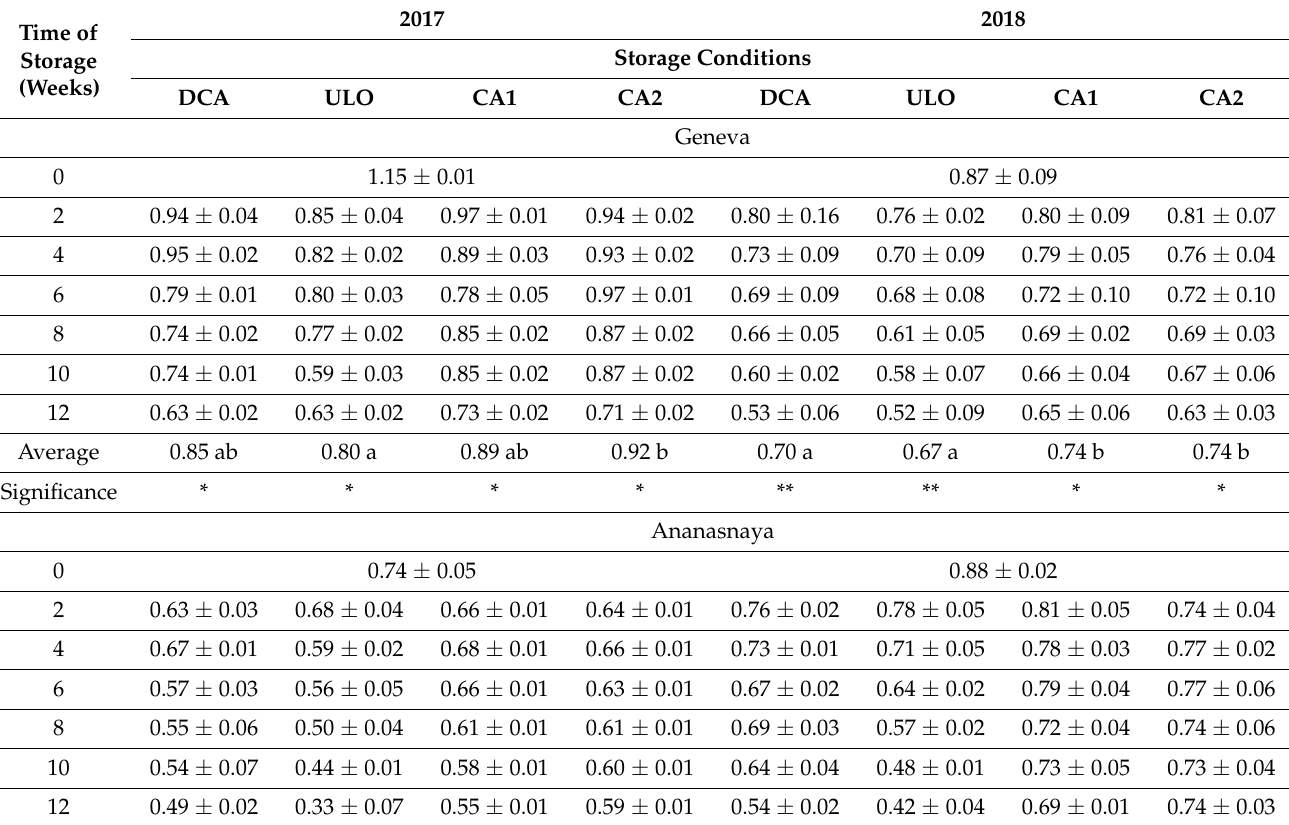
Table 7. Changes in citric acid contents (g · 100 g − 1 F.W.) measured in ‘Geneva’ and ‘Ananasnaya’ minikiwi fruit in the postharvest